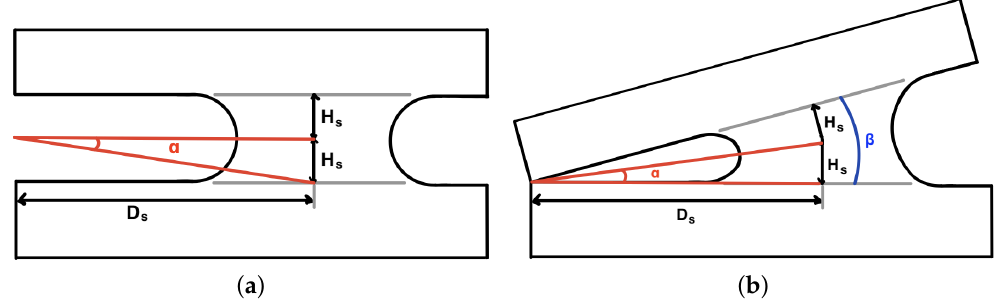
Figure 12. ( a ) Diagram showing the link bending with the joint at rest. ( b ) Bending of the beta link at the point where the morphology makes the blocking